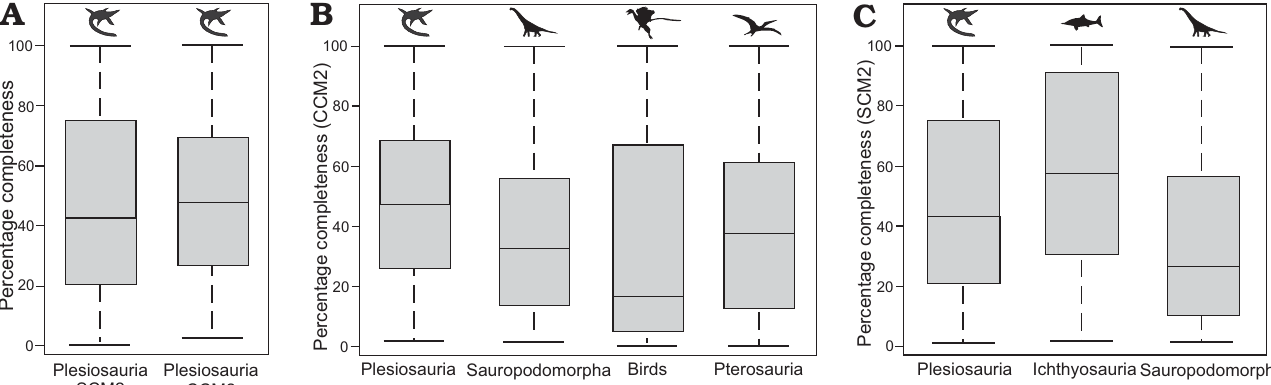
Fig. 5. Box-and-whisker plots showing the distribution of CCM2 and SCM2 data for several major clades of Mesozoic tetrapods. A . Comparison of SCM2 and CCM2 data for plesiosaurs. B . Comparison of CCM2 data for plesiosaurs, sauropodomorphs (from Mannion and Upchurch 2010), birds (from Brocklehurst et al. 2012), and pterosaurs (from Dean et al. 2016). C . Comparison of SCM2 data for plesiosaurs, ichthyosaurs (from Cleary et al. 2015), and sauropodomorphs (from Mannion and Upchurch 2010). All silhouettes are from phylopic.org, and are credited to Adam Stuart Smith ( Plesiosaurus ), Scott Hartman ( Brachiosaurus ), T. Michael Keesey ( Archaeopteryx ), and Gareth Monger ( Pterodactylus , Ichthyosaurus ). Abbreviations: CCM, character completeness metric; SCM, skeletal completeness metric (for detailed explanation of terms see Completeness metrics in Methods section).